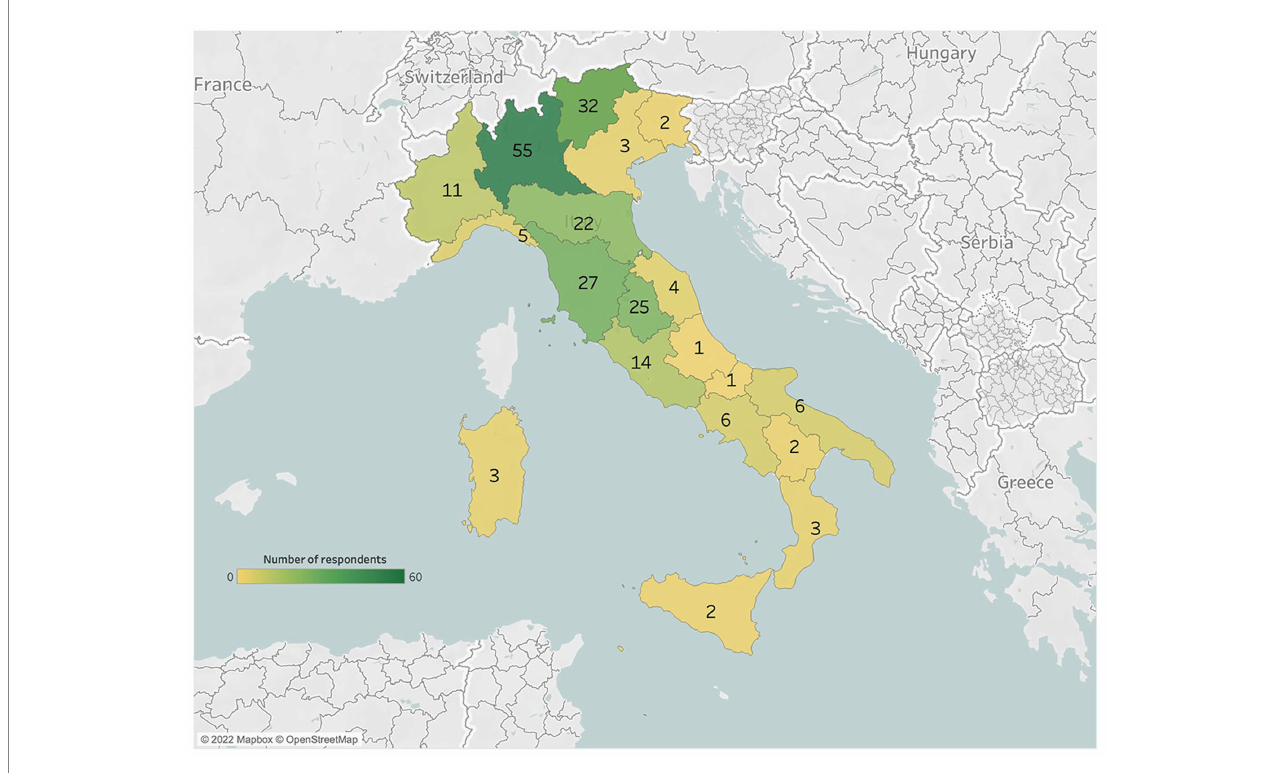
FIGURE 1 The map shows the geographical distribution of HCPs which answered the survey.